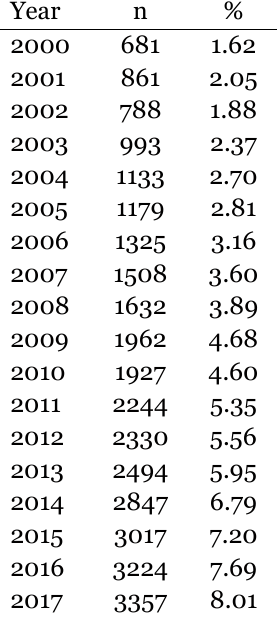
Yearly Distribution of the